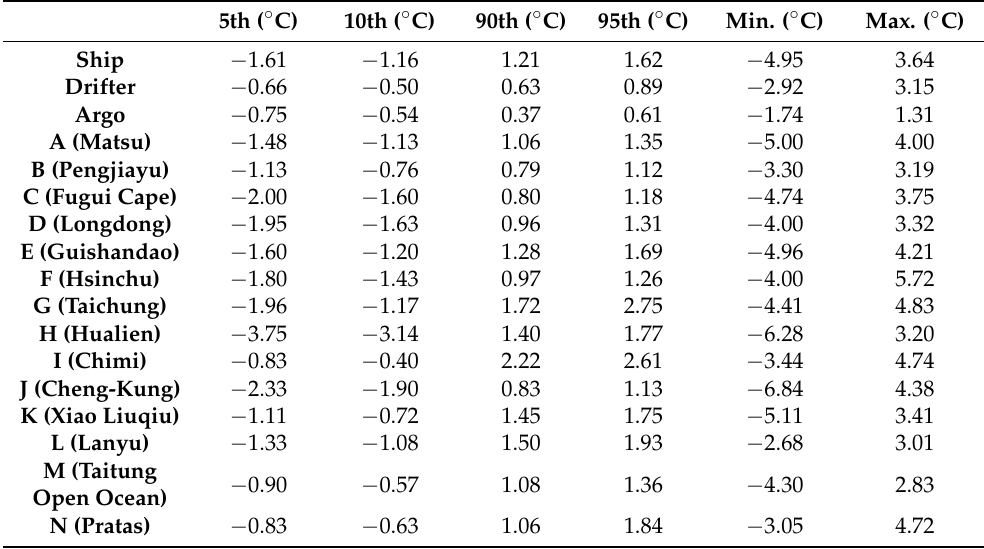
Table 4. Statistics of the bias between bulk SST and skin